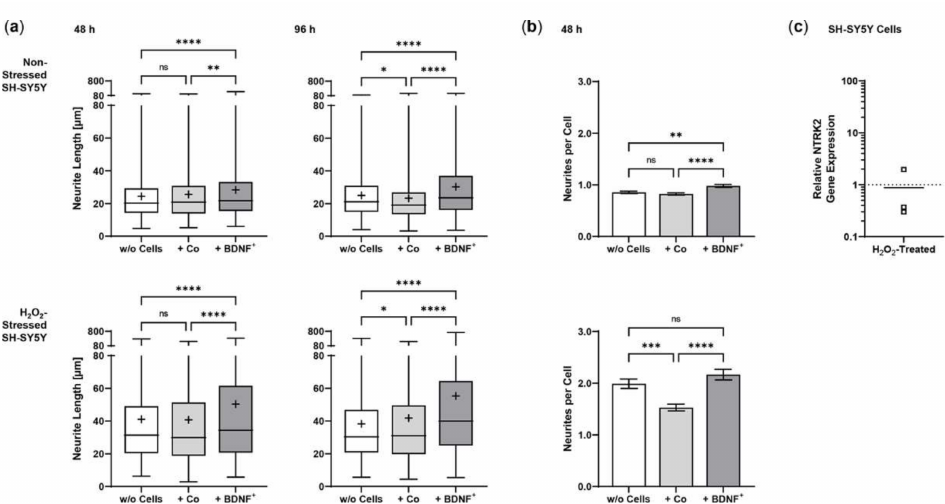
Figure 6. BDNF-mediated neurite outgrowth in non-stressed and H 2 O 2 -stressed SY-SY5Y cells after co-cultivation with ARPE-19 cells. Co-cultures were performed with different passages of BDNF- transfected cells (BDNF + , transfected 0.03 µ g SB100X transposase and 0.47 µ g BDNF transposon plasmid). In each experiment ( n = 4), five images were analyzed for cultures with non-stressed SH-SY5Y cells and seven to ten images for cultures with H 2 O 2 -stressed SH-SY5Y cells. Neurite length was determined by converting pixels into µ m (one pixel = 0.1 µ m), excluding outgrowths of less than 2 µ m. ( a ) Neurite lengths in the different cultures after 48 and 96 h. Non-stressed and H 2 O 2 -stressed SH-SY5Y cells co-cultivated with BDNF + cells showed significantly increased neurite lengths than SH-SY5Y alone (w/o Cells) and SH-SY5Y co-cultivated with non-transfected cells (Co) (ns: not significant, ** p = 0.0041, **** p < 0.0001). Comparison of the two control cultures revealed significant differences only after 96 h (* p < 0.05, Brown-Forsythe and Welch ANOVA tests with Games-Howell’s multiple comparisons test). Number of values: 1158–1281 for non-stressed SH-SY5Y at 48 h, 1095–1369 for non-stressed SH-SY5Y at 96 h, 845–962 for H 2 O 2 -stressed SH-SY5Y at 48 h, 954–1550 for H 2 O 2 -stressed SH-SY5Y at 96 h. Data are presented as box and whisker plots (whiskers: minimum to maximum, mean values indicated by +). ( b ) Neurites per cell in the different cultures after 48 h. Significances were found for non-stressed SH-SY5Y cells co-cultivated with BDNF + cells compared to both controls (ns: not significant, ** p = 0.0017, **** p < 0.0001). In H 2 O 2 -stressed SH-SY5Y cells, the differences were significant compared to the co-cultivation with Co cells (*** p = 0.0001, **** p < 0.0001, Brown-Forsythe and Welch ANOVA tests with Games-Howell’s multiple comparisons test). Number of values: 1181–1496 for non-stressed SH-SY5Y at 48 h, 444–553 for H 2 O 2 -stressed SH-SY5Y at 48 h. Data are presented as mean ± SEM. ( c ) NTRK2 gene expression was analyzed by qPCR. Expression in SH-SY5Y cultures with H 2 O 2 exposure ( n = 3) was related to that in cultures without H 2 O 2 exposure ( n = 3), which was set to 1 (dashed line). The mean value of the H 2 O 2 -treated cultures was almost 1 (no significance, one sample t